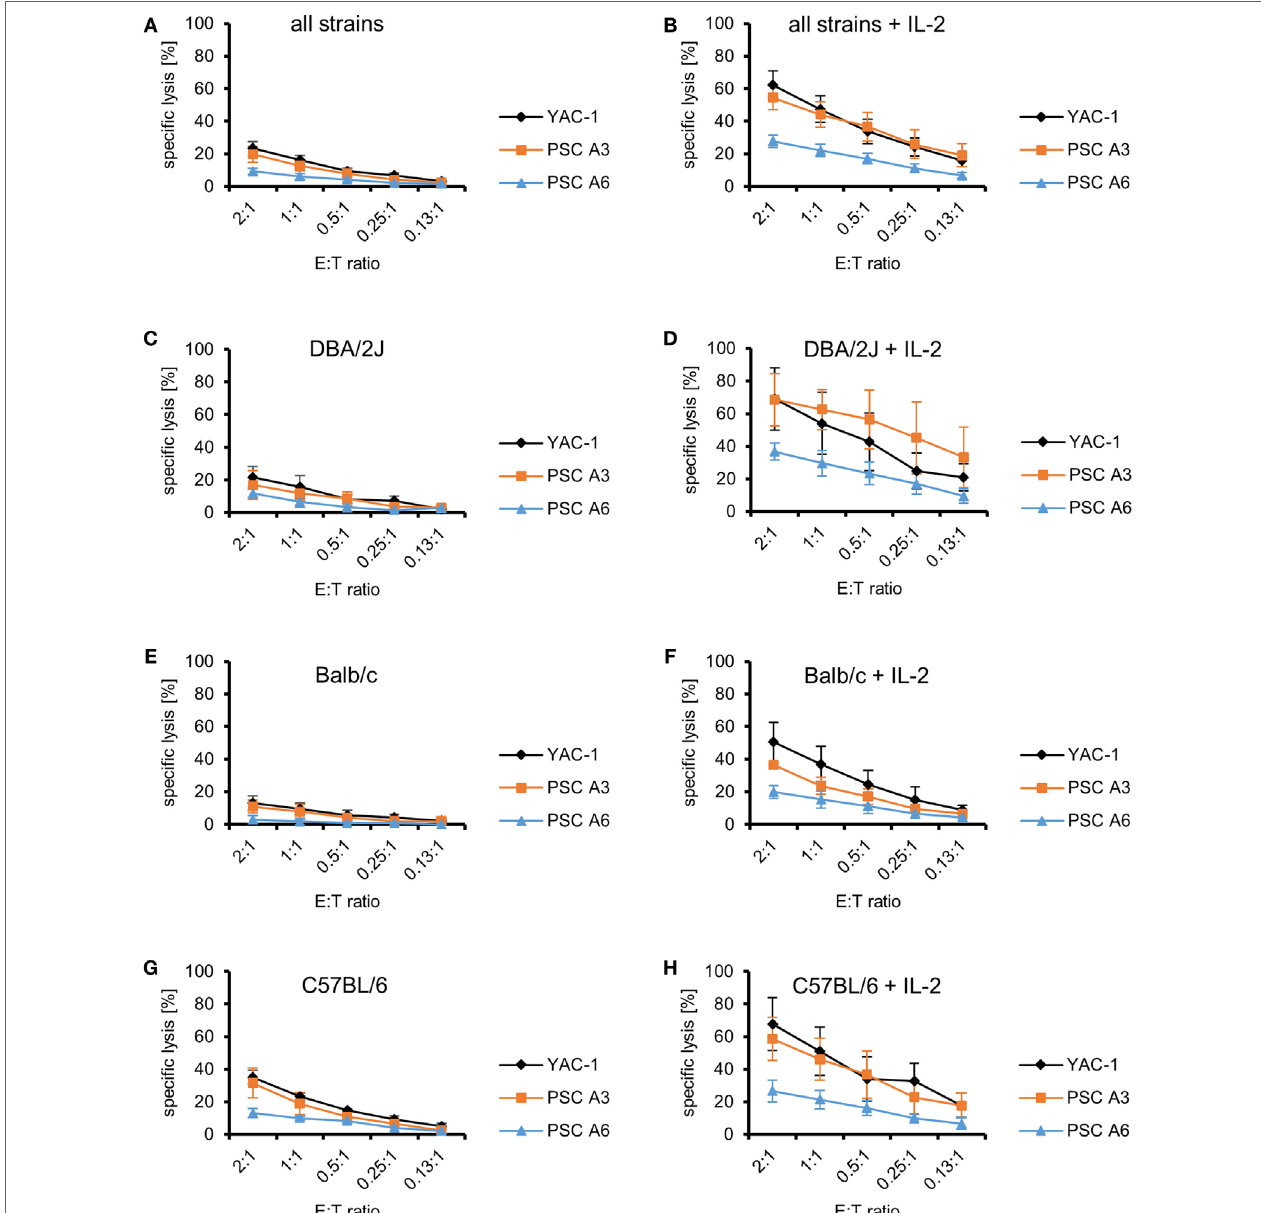
FigUre 2 | Comparison of the killing of parthenogenetic stem cell (PSC) A3, PSC A6, and YAC-1 target cells by resting and IL-2-activated natural killer (NK) cells of three mouse strains. (a) A summary of means of specific lysis and the SEM is shown as determined by 51 Cr-release assays of the three target cell lines YAC-1 ( n = 9), PSC A3 ( n = 9), and PSC A6 ( n = 9) by resting NK cells from three mouse strains (DBA/2J, n = 3; Balb/c, n = 3; C57BL/6, n = 3). (B) A summary of means of specific lysis and the SEM is shown as determined by 51 Cr-release assays of the three target cell lines YAC-1 ( n = 9), PSC A3 ( n = 9), and PSC A6 ( n = 9) by IL-2-activated NK cells from three mouse strains (DBA/2J, n = 3; Balb/c, n = 3; C57BL/6, n = 3). (c,D) Summary of means of specific lysis and the SEM by resting (c) or IL-2- activated NK cells (D) derived from DBA/2J mice ( n = 3) of YAC-1 ( n = 3), PSC A3 ( n = 3), and PSC A6 cells ( n = 3). (e,F) Summary of means of specific lysis and the SEM by resting (e) or IL-2-activated NK cells (F) derived from Balb/c mice ( n = 3) of YAC-1 ( n = 3), PSC A3 ( n = 3), and PSC A6 cells ( n = 3). (g,h) Summary of means of specific lysis and the SEM by resting (g) or IL-2-activated NK cells (h) derived from C57BL/6 mice ( n = 3) of YAC-1 ( n = 3), PSC A3 ( n = 3), and PSC A6 cells ( n =